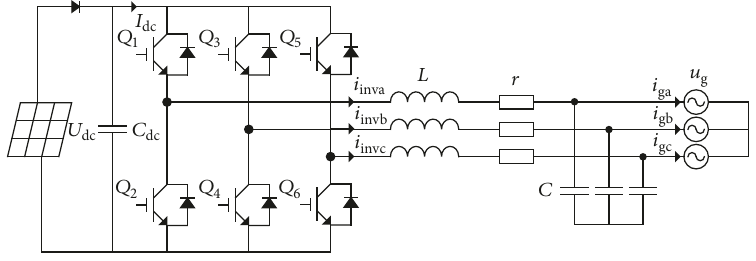
Figure 1: Structure of photovoltaic grid-connected system.